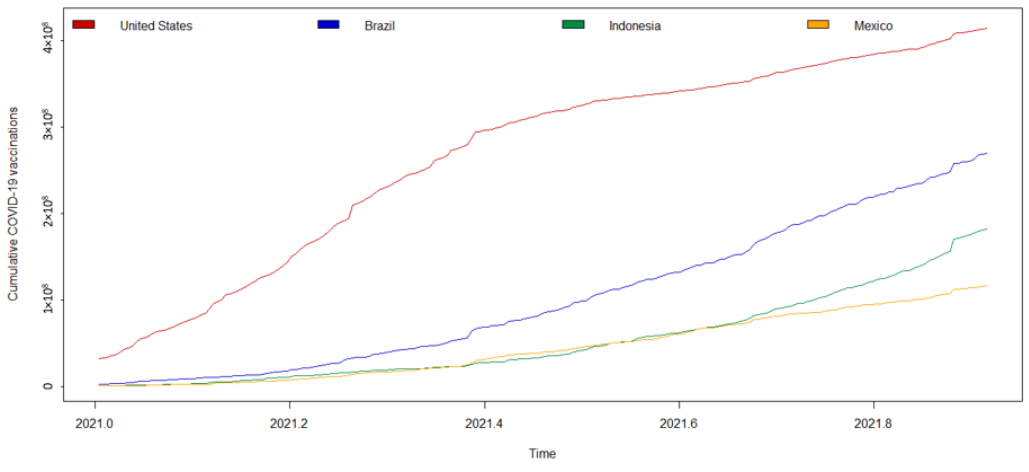
Figure 2. Cumulative numbers of vaccine doses administered in different